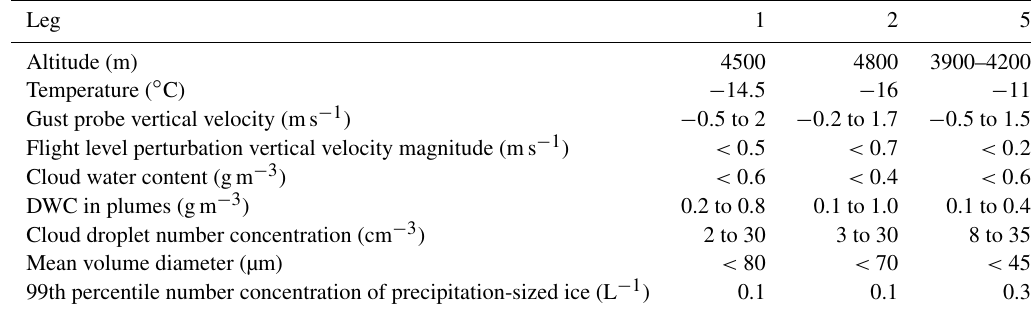
Table 2. Flight level cloud characterization information between legs 1, 2, and